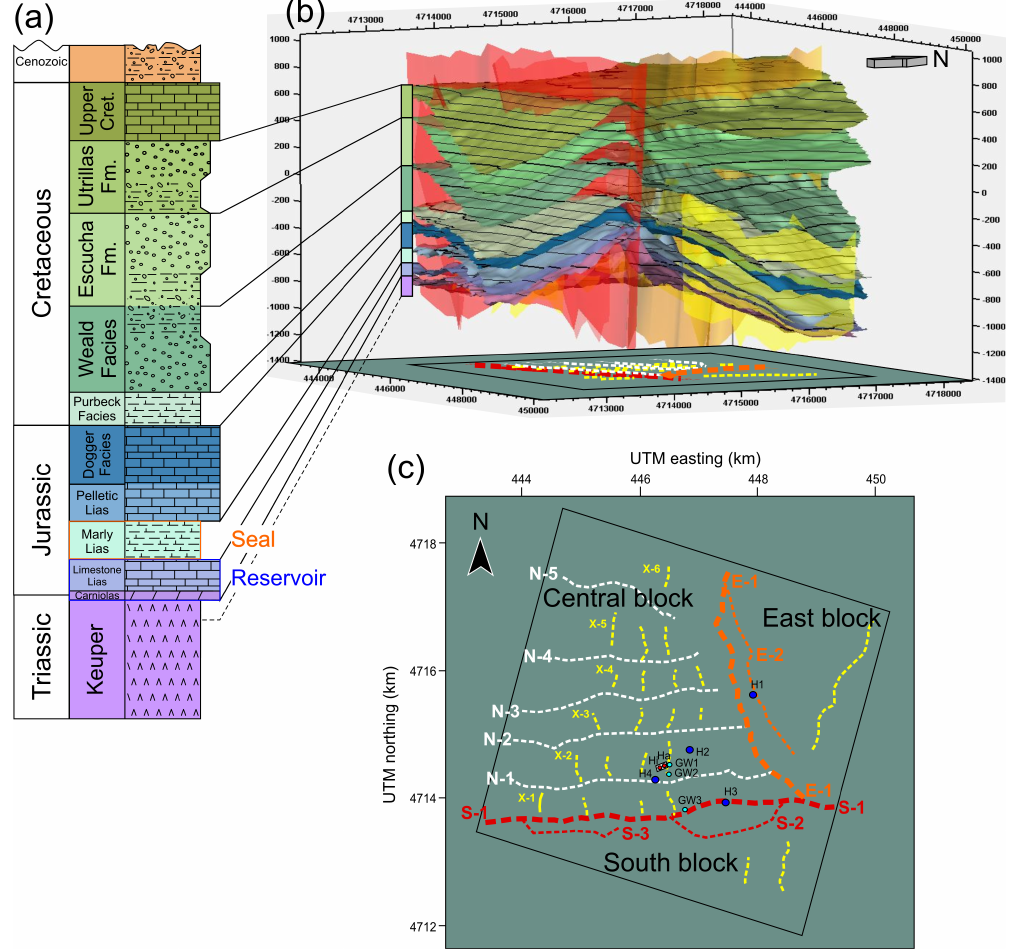
Figure 2. Description of the lithologies and structures interpreted in the subsurface of Hontomín (after Alcalde et al., 2014). (a) Stratigraphic column with relative thicknesses of the sedimentary units. (b) Eight-layered structural model interpreted from the seismic and well-log data; the eight surfaces interpreted are: Anhydrite Unit (top Keuper), Limestone Lias (top of the reservoir formation), Marly Lias (top of the primary seal formation), Dogger facies, Purbeck facies, Weald facies, Escucha Fm., and Utrillas Fm. (c) Sketch with the general distribution and labelling of the main faults interpreted in the study area, including: “S-faults” in red, “E-faults” in orange, “N-faults” in white, and “X-faults” in yellow; S-1 corresponds to the South Fault and E-1 corresponds to the East Fault; these two faults determine the remarkable division of the study area in three blocks: the east, the central, and the south block. The position of the oil exploration and water wells are also included for